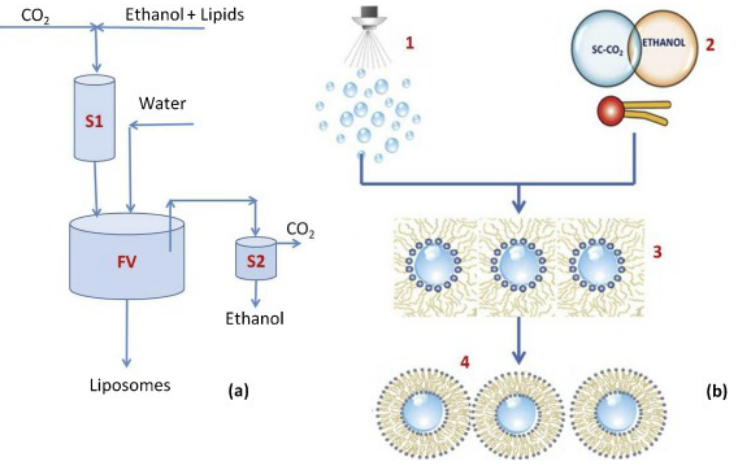
Figure 2. Supercritical-assisted liposome formation; SuperLip process layout ( a ) and a sketch of the phenomena occurring in it ( b ), adapted from Trucillo et al. [36] .